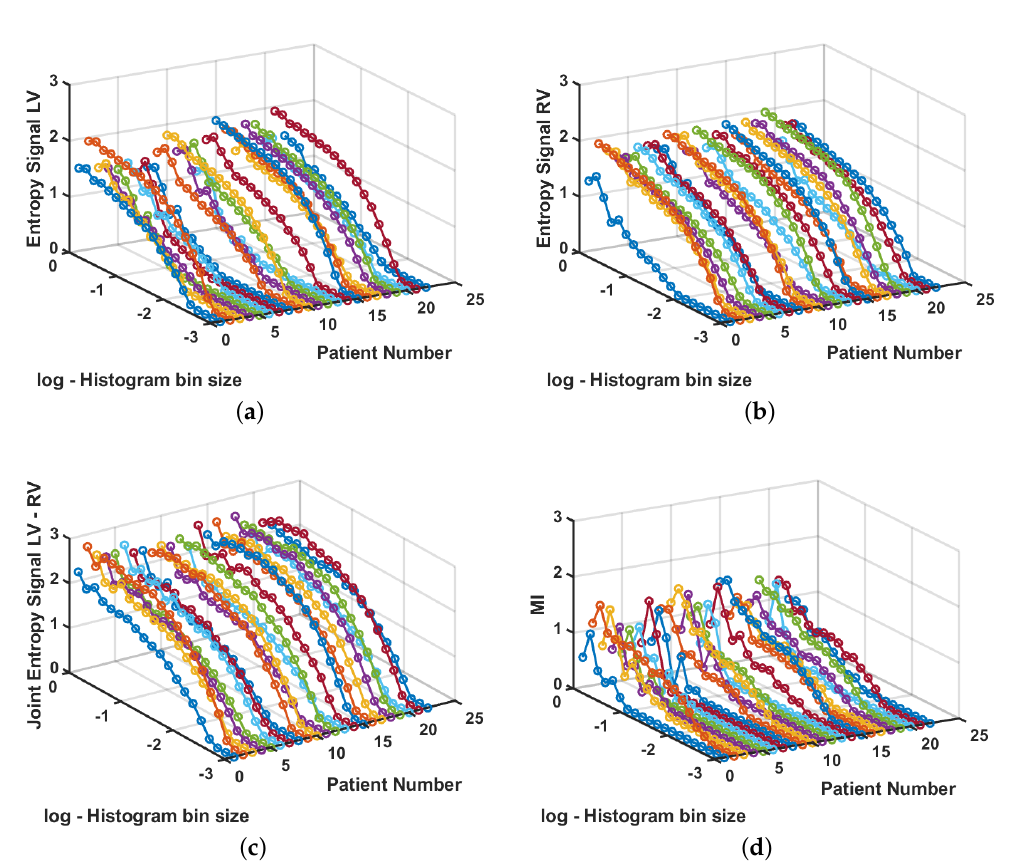
Figure 7. Entropy, Joint Entropy, and MI estimation in cardiac signals. ( a ) Entropy for signals from the LV. ( b ) Entropy for signals from the RV. ( c ) Joint entropy for signals from LV and from RV in each patient. ( d ) MI for signals from LV and